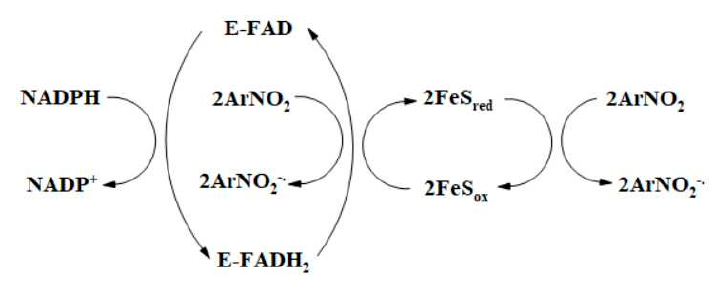
Table 2. Potentiometric and kinetic characteristics of flavoenzymes FeS reductases and FeS proteins. Redox Potential Enzyme vs. NHE, pH 7.0 Bovine adrenal cortex NADPH: adrenodoxin